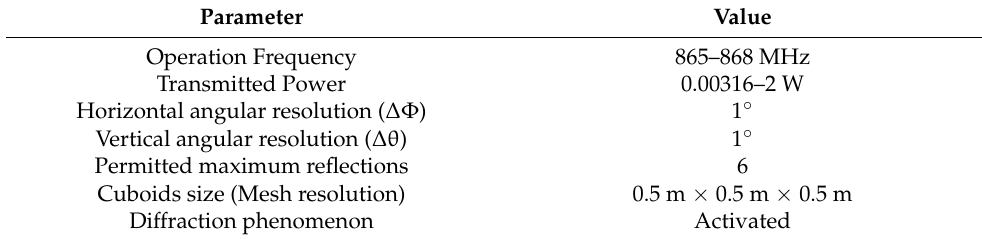
Table 4. Variable Configuration for 3D Ray Launching